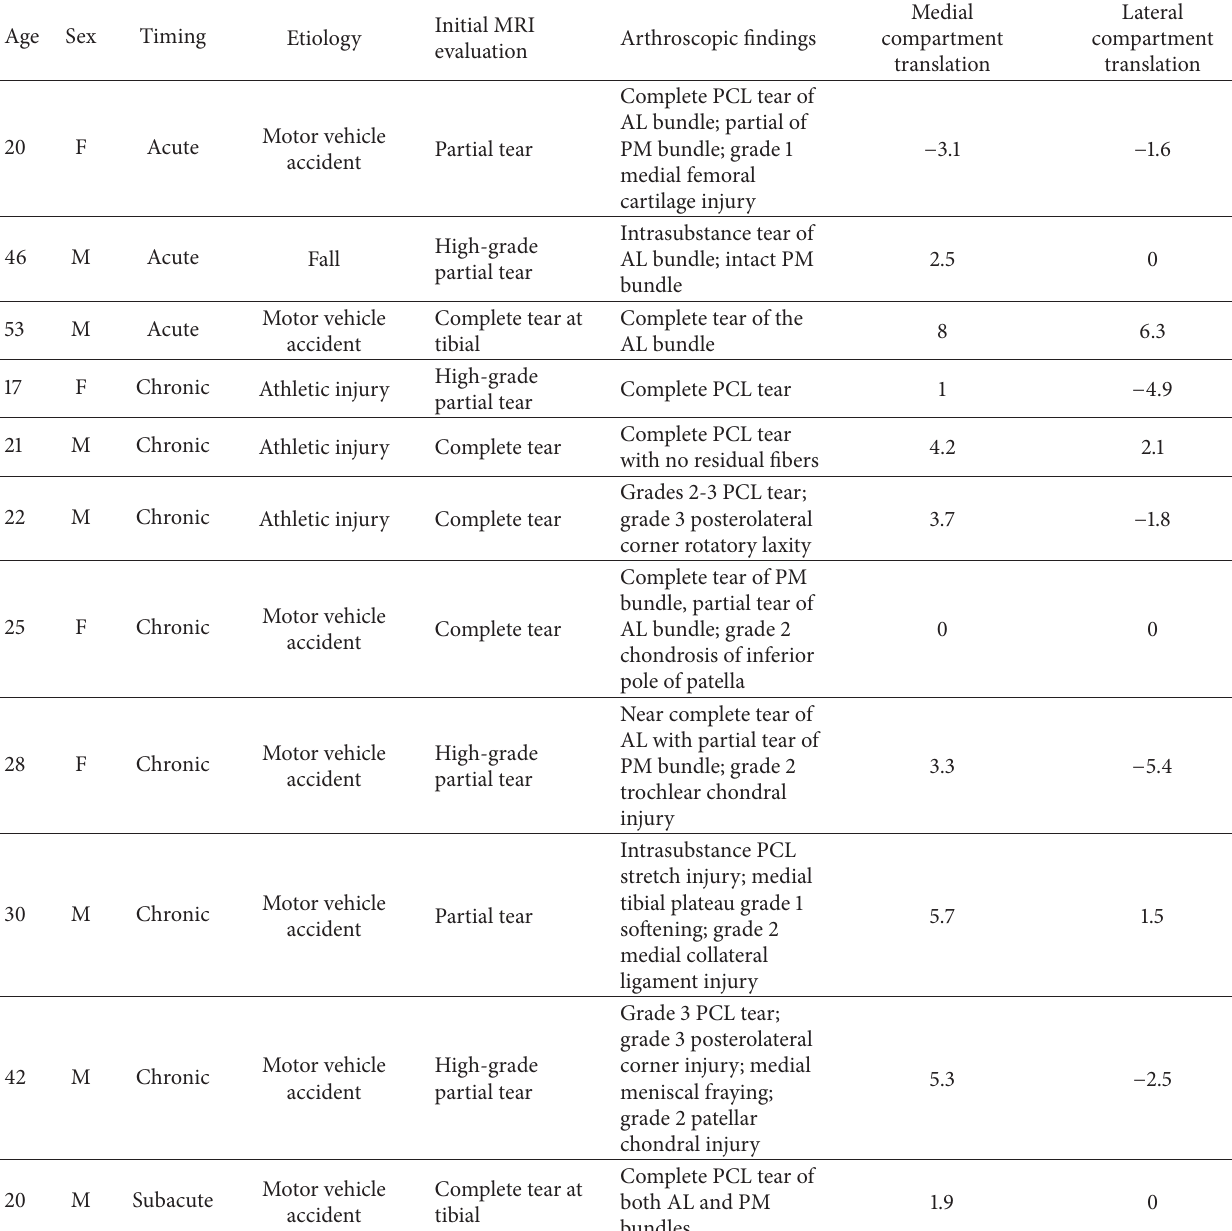
Table 2: Imaging findings in PCL